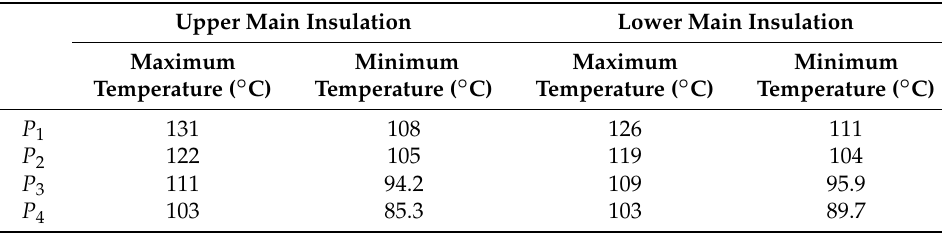
Table 3. The maximum and minimum temperature on P 1 – P 4 .